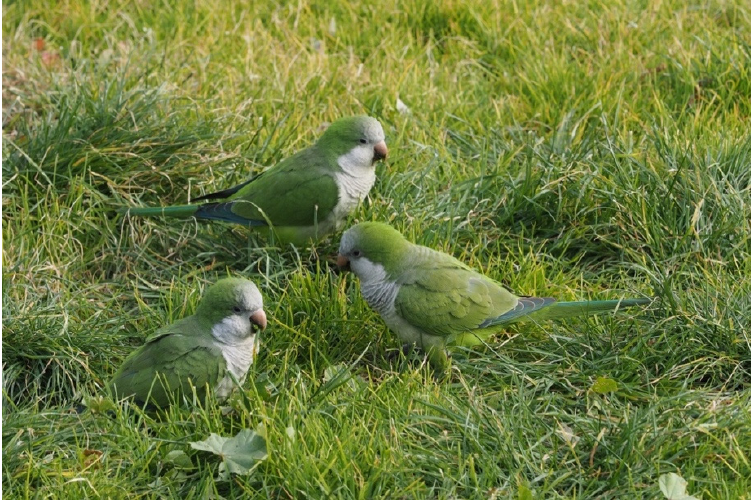
Figure 1. Three monk parakeets on the grass in Rome, Italy. Source: Vito Giaccari/Pexels.